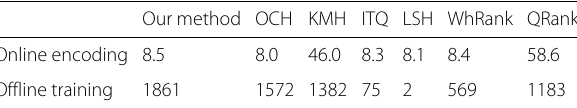
map 1 million GIST to 128-bit binary code during the online encoding